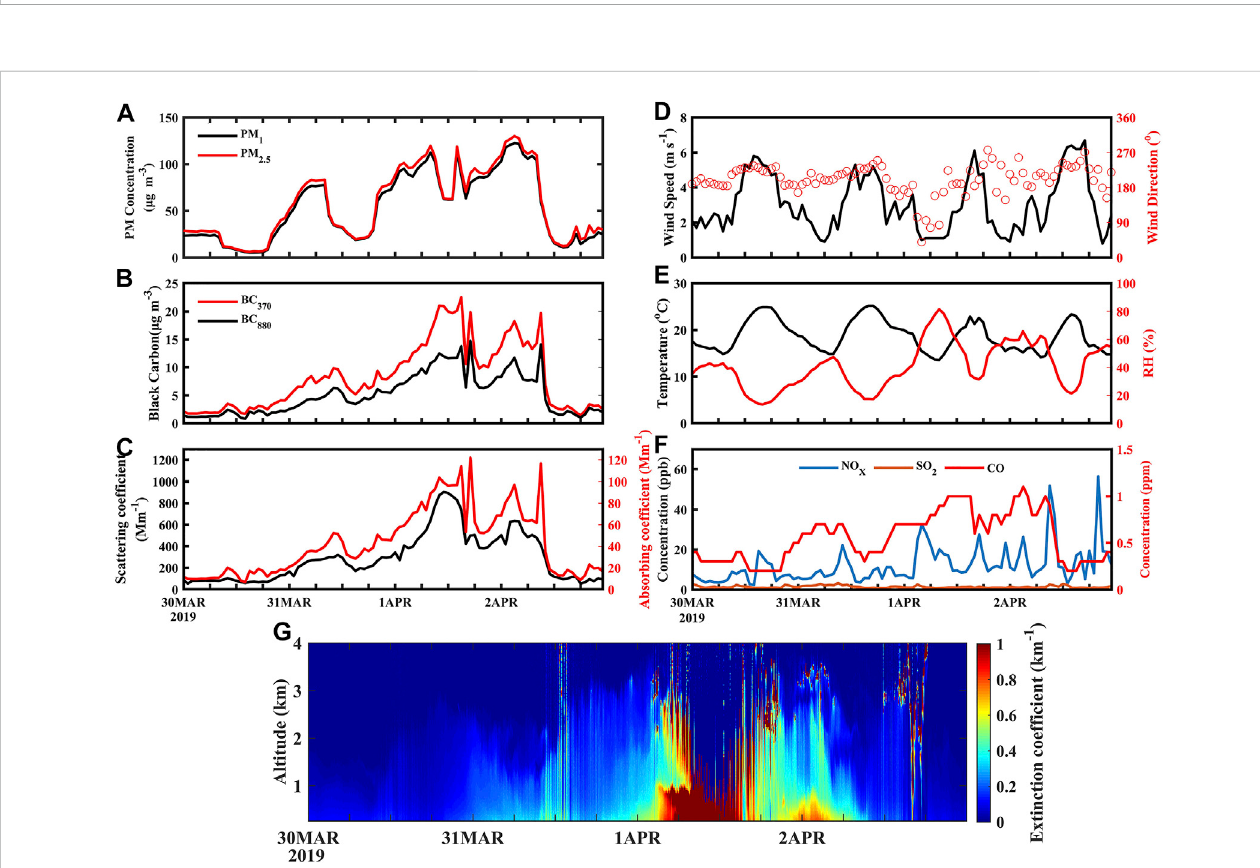
FIGURE 3 Hourly mean observations of (A) PM 2.5 and PM 1 concentrations ( μ g m − 3 ), (B) BC 370 and BC 880 concentrations ( μ g m − 3 ), (C) aerosol scattering coef fi cient (525 nm) and absorbing coef fi cient (532 nm) (Mm − 1 ), (D) wind speed (m s − 1 ) and wind direction ( ° ), (E) temperature ( ° C) and relative humidity (RH, %), (F) , NOx, SO 2 (ppb)andCO concentrations(ppm)and (G) theverticalpro fi lesofaerosolextinctioncoef fi cient(km − 1 )attheChenggong stationfrom30Marchto2April